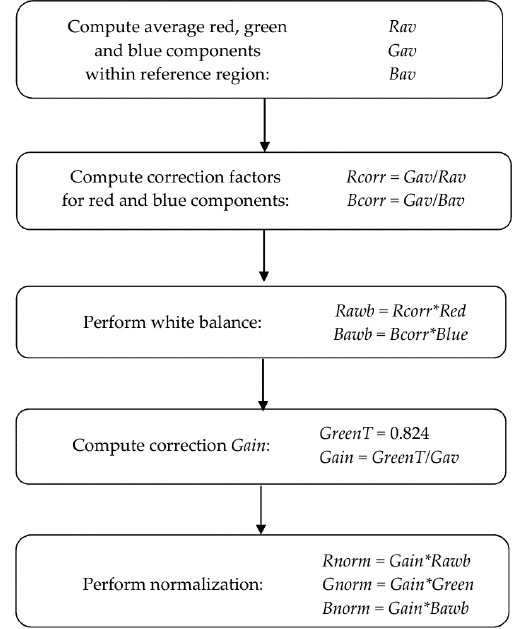
Figure 4. The diagram of the algorithm of an automatic white balance and brightness normalization.